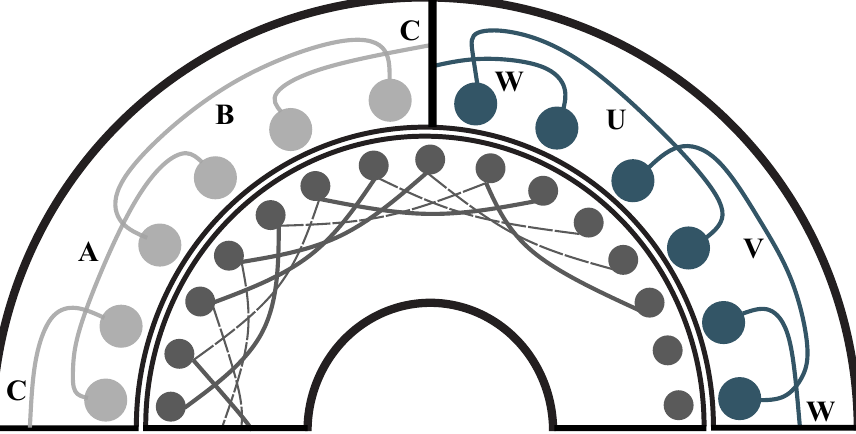
Figure 2. Thompson motor winding illustration